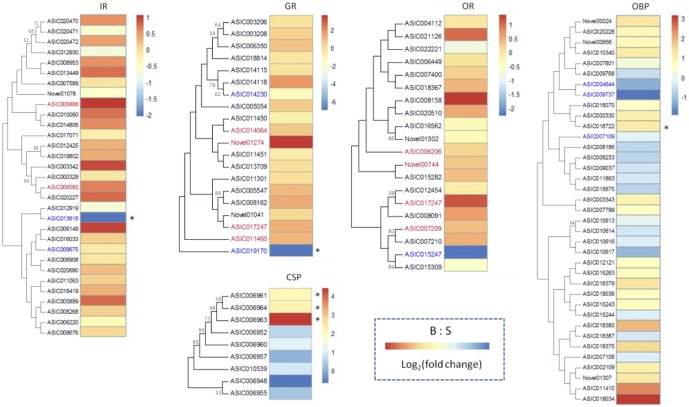
Differential antennal abundances of chemosensory genes.Heat maps for the five most abundant chemoreceptor gene families in the antenna. Only transcripts that were detectable in one or both species are displayed. Colors indicate a normalized log2(fold change), denoting enrichment in either S group (blue) or B group (red); Chemoreceptors are color coded if they were only classified as being detectable in S (blue) or in B (red). “*” marks the genes of significant differential abundance with the FDR-adjusted P-value (padj) less than 0.05.